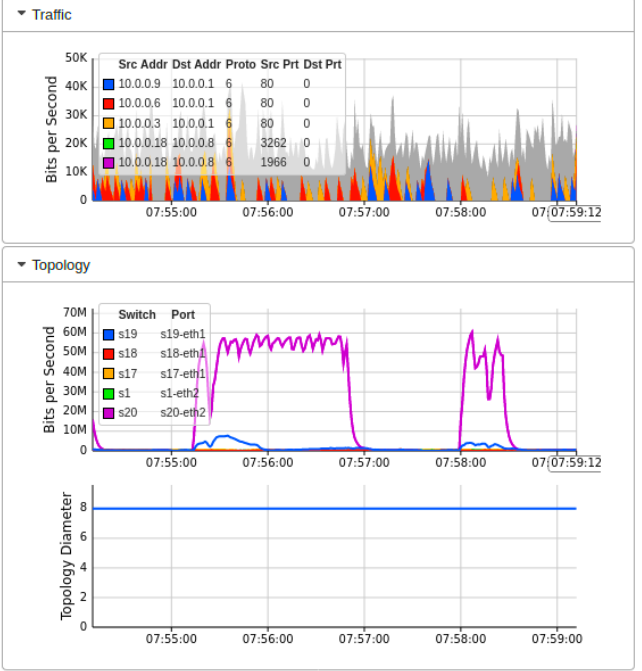
Figure 16. Mininet performance dashboard during real-time DDoS attacks